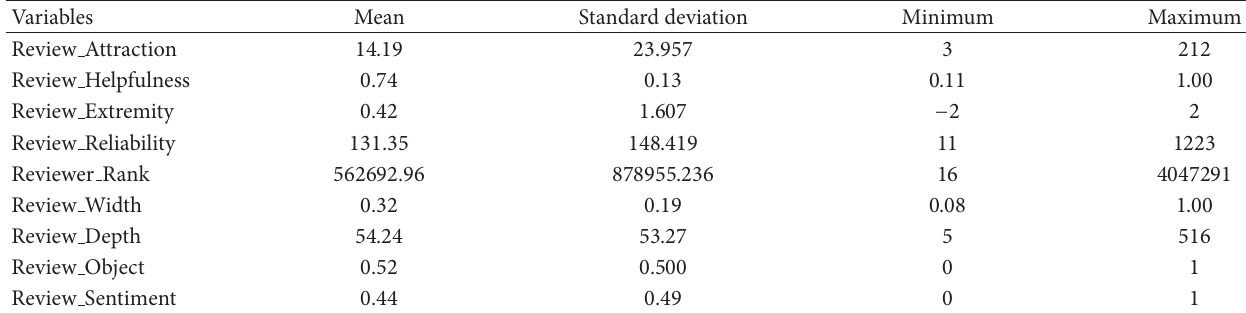
Table 3: Descriptive statistics of